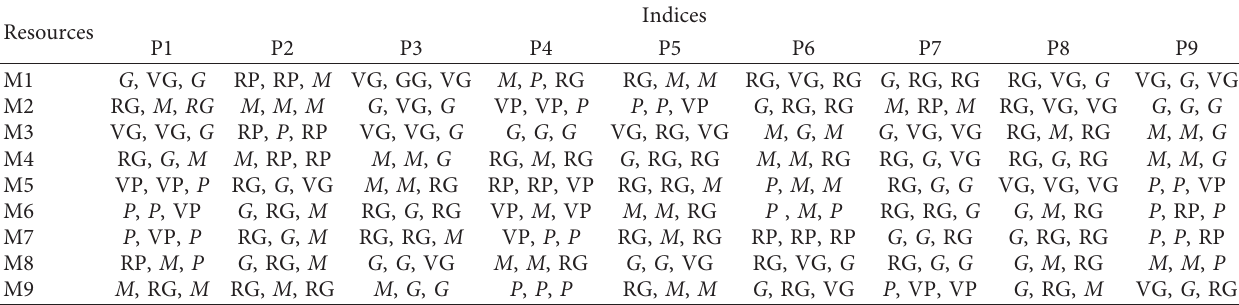
Table 2: Fuzzy evaluation matrix of module innovation resources.